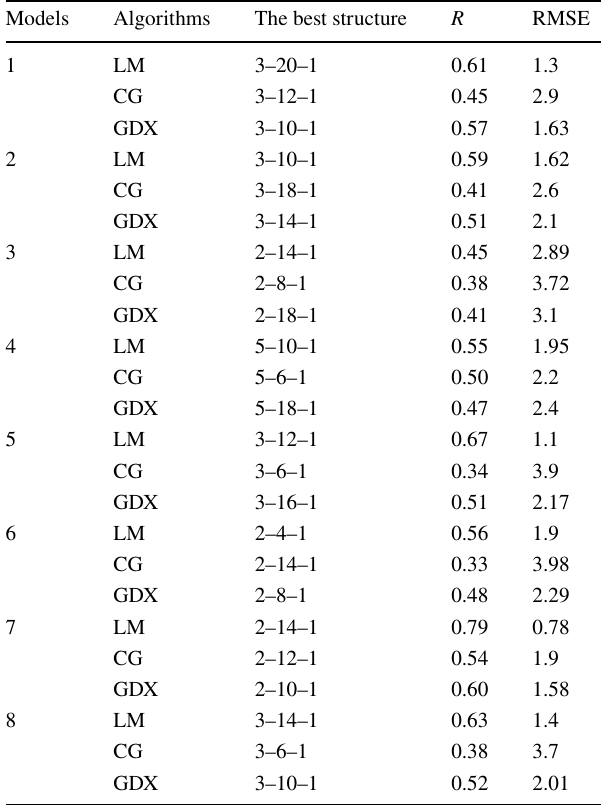
Table 5 The results of alluvial springs discharge simulation by the use of ANN in the eight network structure in the testing stag Models